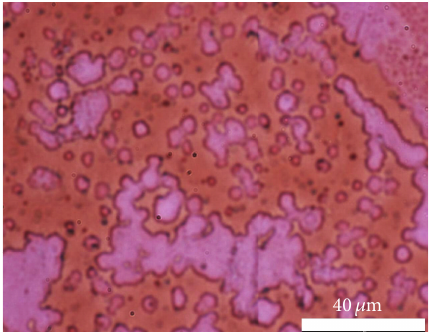
Figure 6: Optical micrograph of a CdS film coated with 60 cycles ALD after a photoelectrochemical